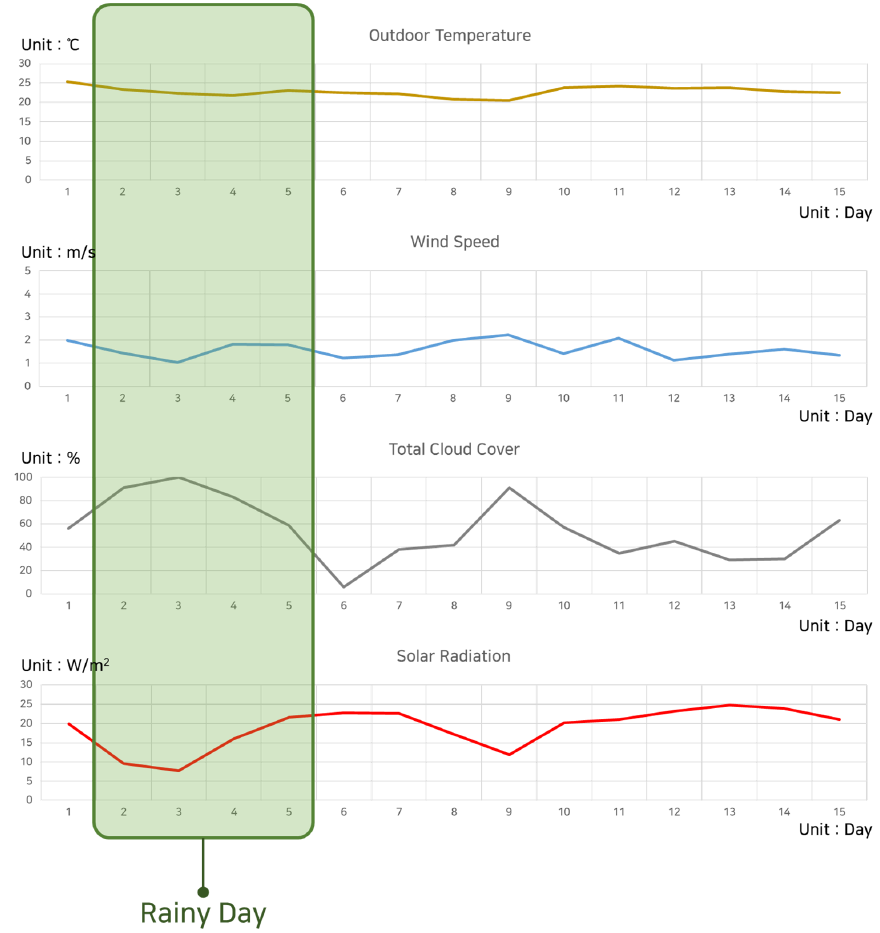
Figure 9. Weather conditions in autumn season.